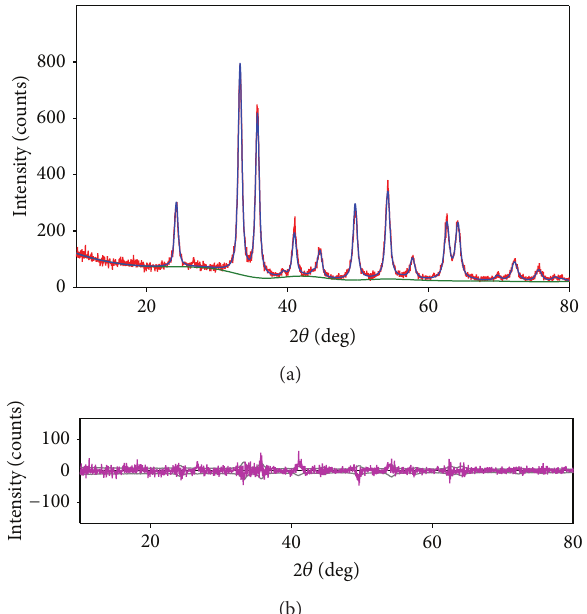
Figure 3: An example of pattern fitting using Rietveld refinements. The net difference between the observed and measured profile is given on bottom of plot.